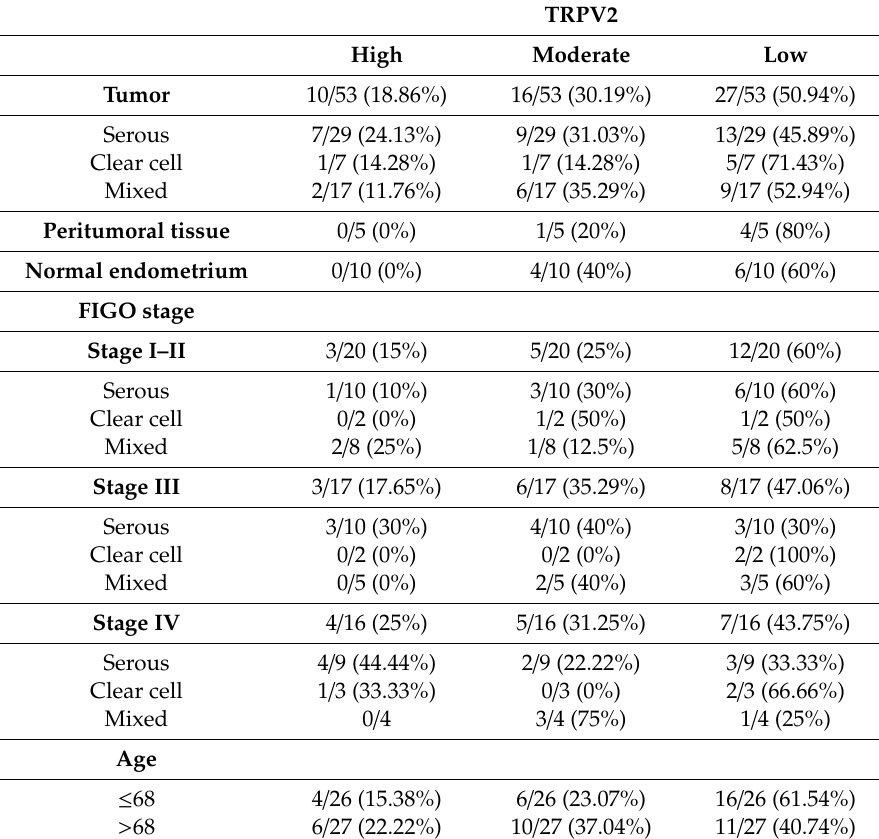
Table 1. Expression of TRPV2 in EC biopsies according to di ff erent clinicopathological characteristics, in EC biopsies, peritumoral tissue and normal endometrium. Percentages of samples positive for TRPV2 expression are